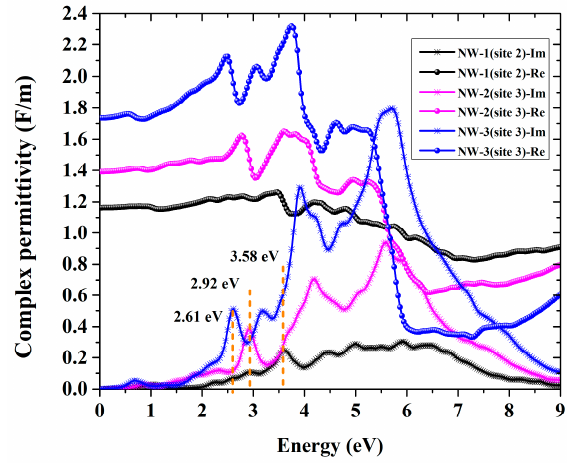
Figure 5. Dielectric function of Cr 2+ :ZnSe NWs of different sizes.